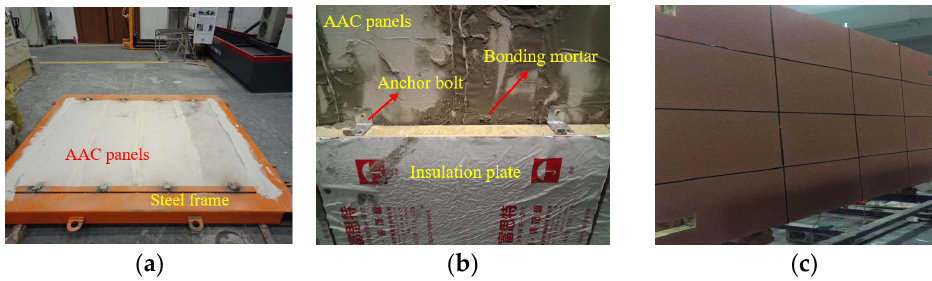
Figure 3. Assemblage of the enclosure system. ( a ) Assembly of AACPs and steel frame. ( b ) Assembly of AACPs and insulation plate. ( c ) Side view of the enclosure